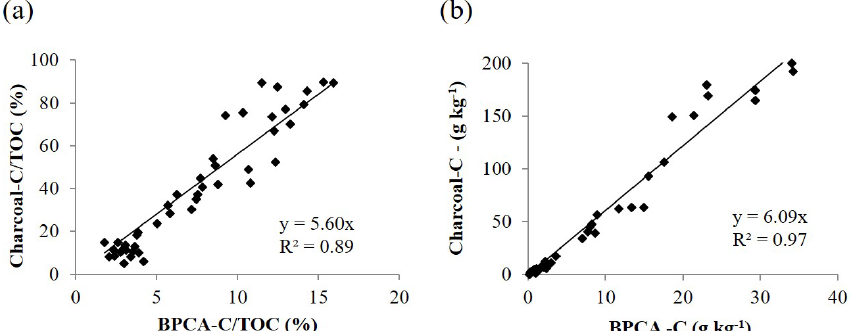
Figure 7. Charcoal-C content estimated by differential scanning calorimetry against BPCA-C content in the soils from Germany, expressed as a fraction of TOC content (a) or in absolute terms (b)